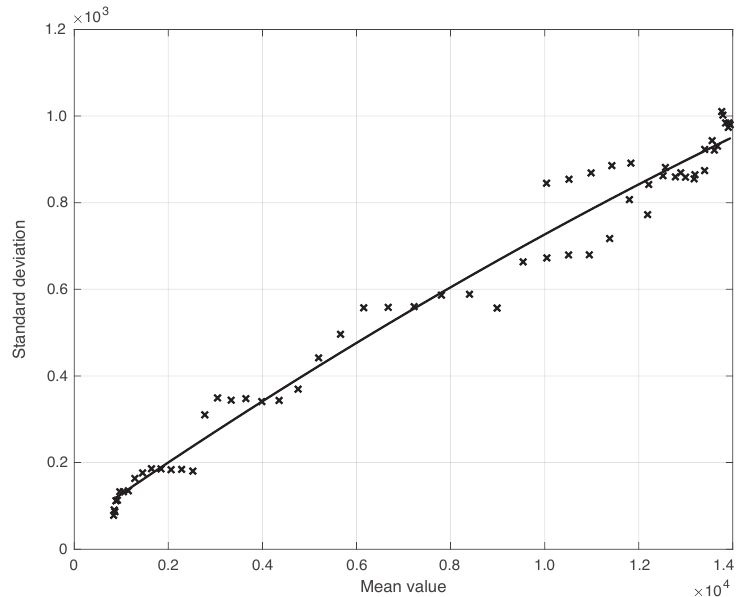
Figure 3. Standard deviation of the real SARS-CoV-2 Italian first symptoms sequence from 21 Septem- ber to 20 November 2020, illustrated in Figure 1, as a function of their expected value. The continuous line represents the best fit with a degree 2 polynomial